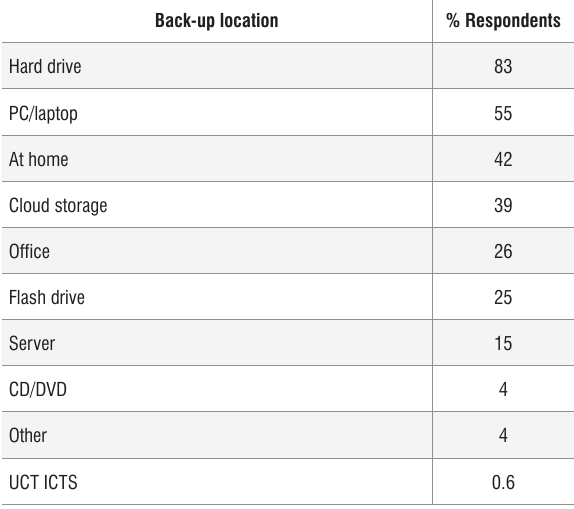
Percentage of respondents who back up data at each location Back-up location % Respondents